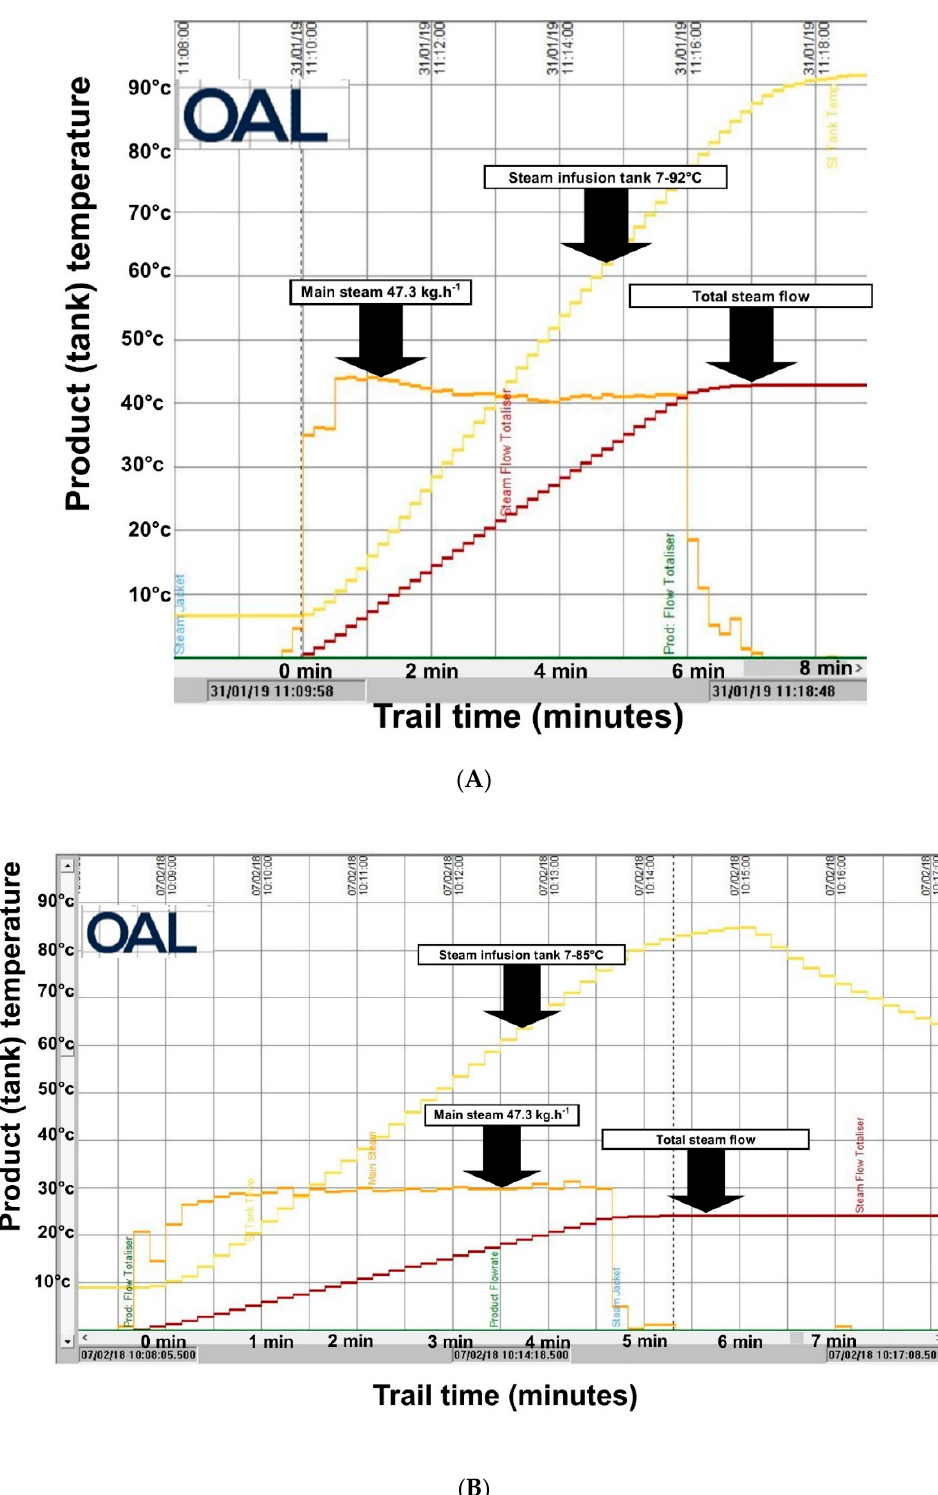
Figure 3. ( A ) The Steam Infusion Vaction TM Pump system data for the heating of 400 kg water. The temperature in the Steam Infusion heated kettle starts at 7 °C and finishes at 92 °C over the duration of the cooking time of 8 min. ( B ) The Steam Infusion Vaction TM Pump system data for the heating of 400 kg chocolate custard. The temperature in the Steam Infusion heated kettle starts at 9 °C and finishes at 85 °C over the duration of the cooking time of 6.5 min.